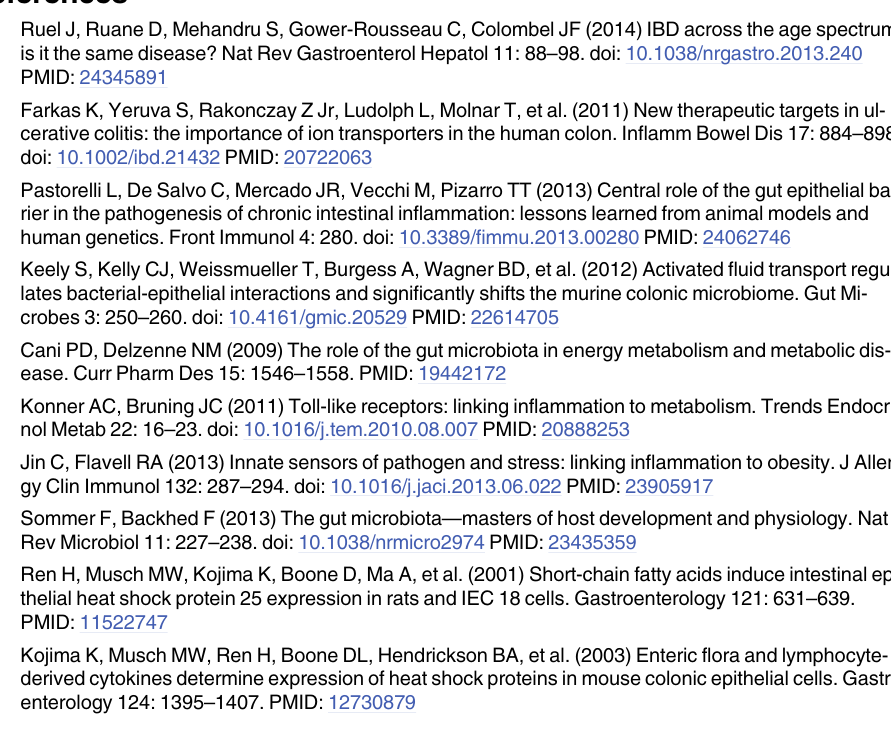
S4 Table. Crypt architecture of colonic mucosa in pigs born to control or antibiotic-treated sows and fed a low (LF) or a high (HF) fat diet between 140 and 169 days of age (LSmeans and SEM, n = 10 per treatment and diet). S5 Table. Electrophysiological characteristics of basal and monochloramine-stimulated co- lonic mucosa of pigs born to control or antibiotic-treated sows and fed a low (LF) or a high (HF) fat diet between 140 and 169 days of age (LSmeans and SEM, n = 8 – 10 per treatment and diet). S6 Table. Concentrations of TLR-stimulants in rectal contents of pigs born to control or antibiotic-treated sows and fed a low (LF) or a high (HF) fat diet between 140 and 169 days of age (LSmeans and SEM, n = 8 – 10 per treatment and